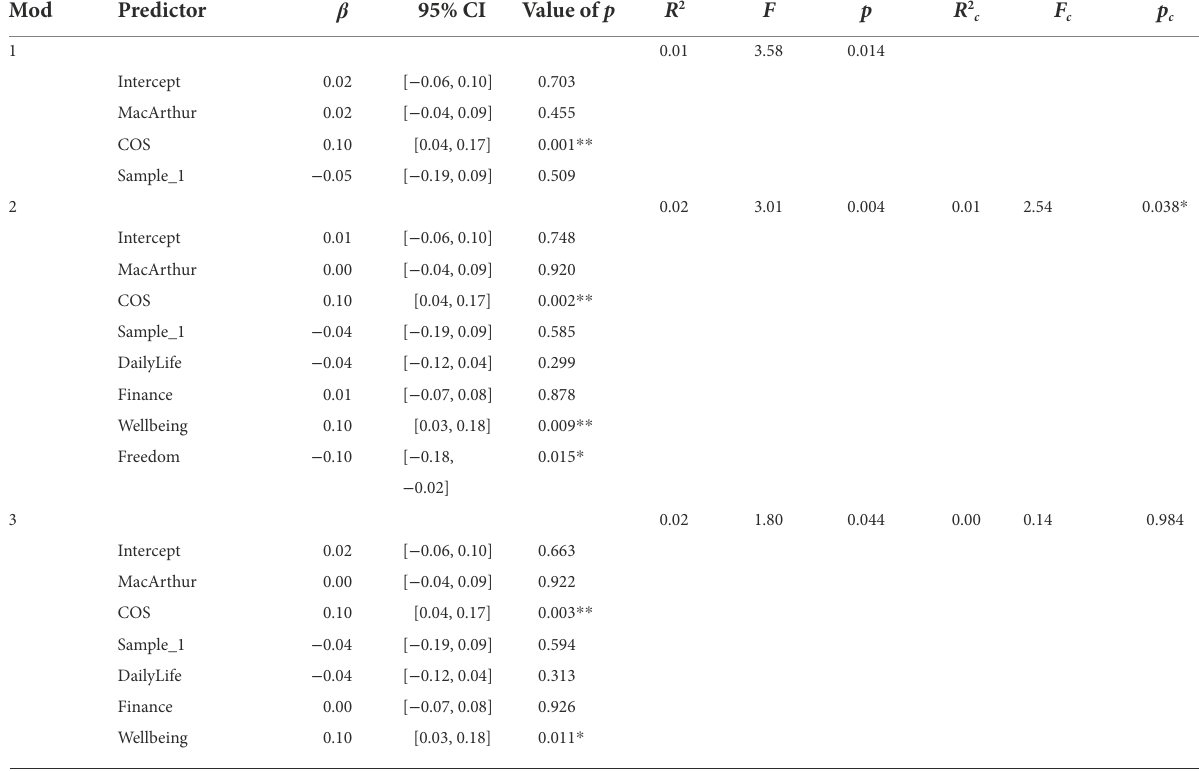
TABLE 4 (a) Hierarchical regression for the outcome variable PGG-time: standardized β coefficients, 95% CIs and change statistics for four models ( N = 900).